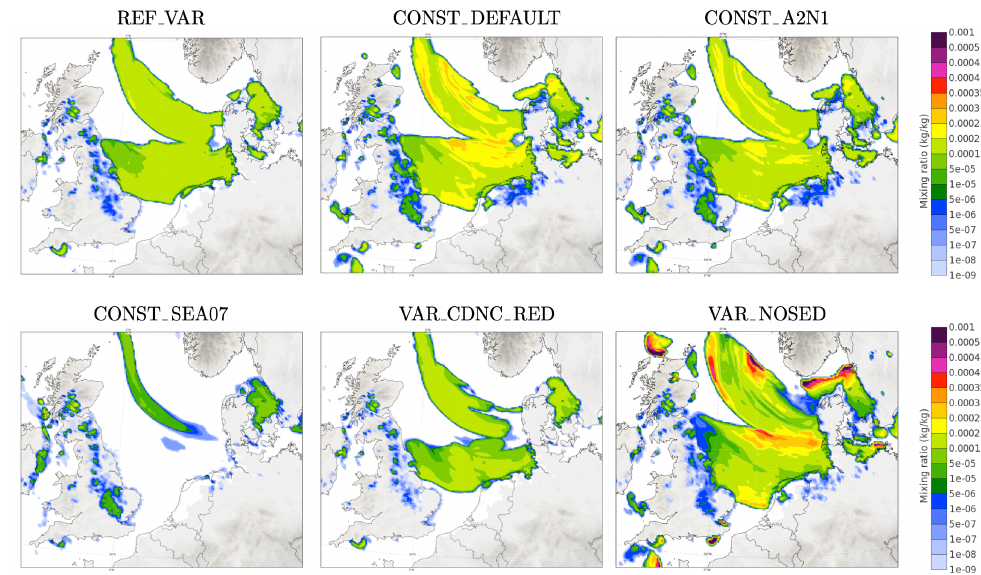
Figure 9. North Sea. liquid–water mixing ratio (kg/kg) at the lowest model level, +023 h (23 March 2012 at 11 UTC).